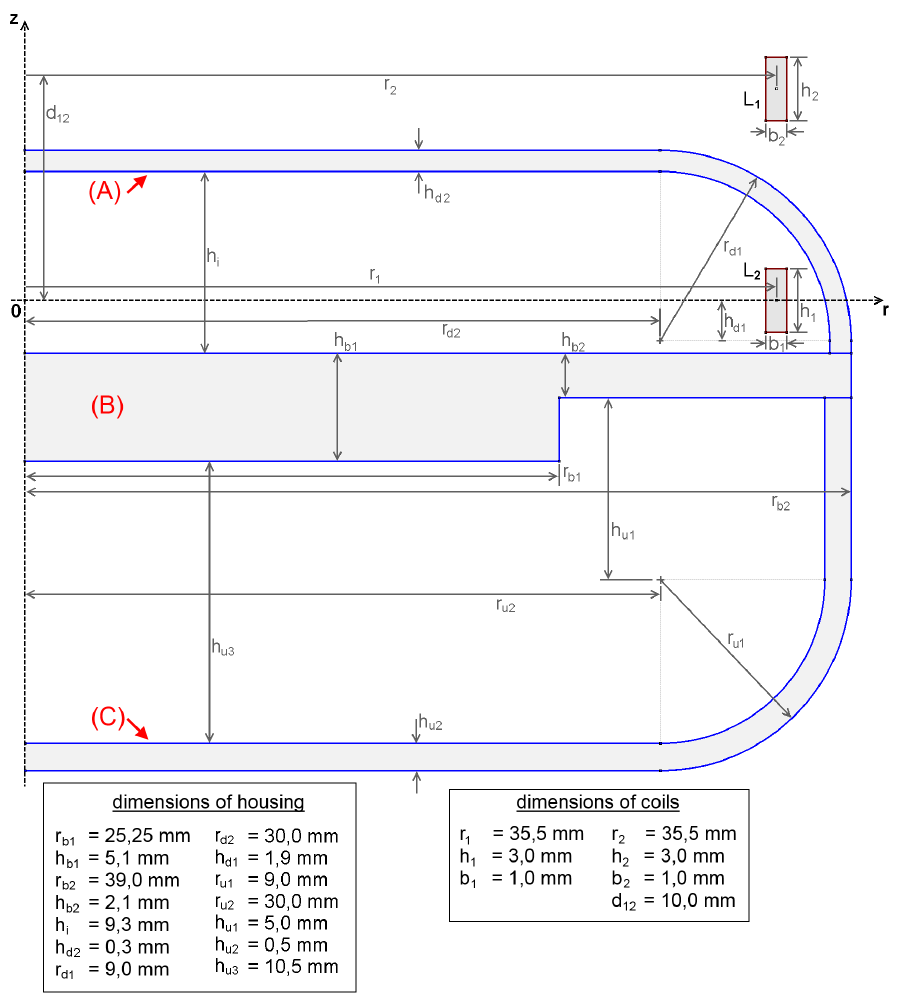
Figure A1. FEM model of the housing and the coils for the estimation of transmission parameters with dimensions, based on a prototype housing of an implantable infusion pump. This model is axially symmetric to the z -axis